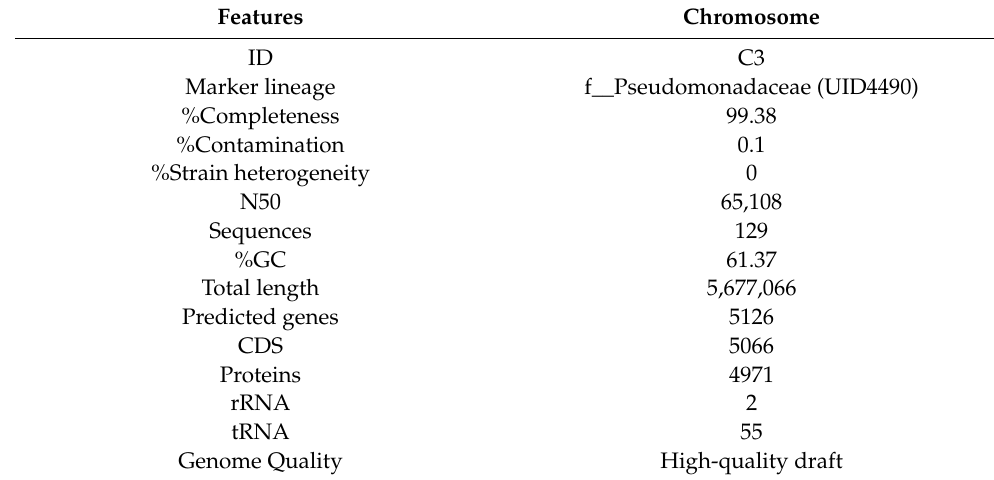
Table 1. Molecular features that determine the genome of Pseudomonas sp. strain